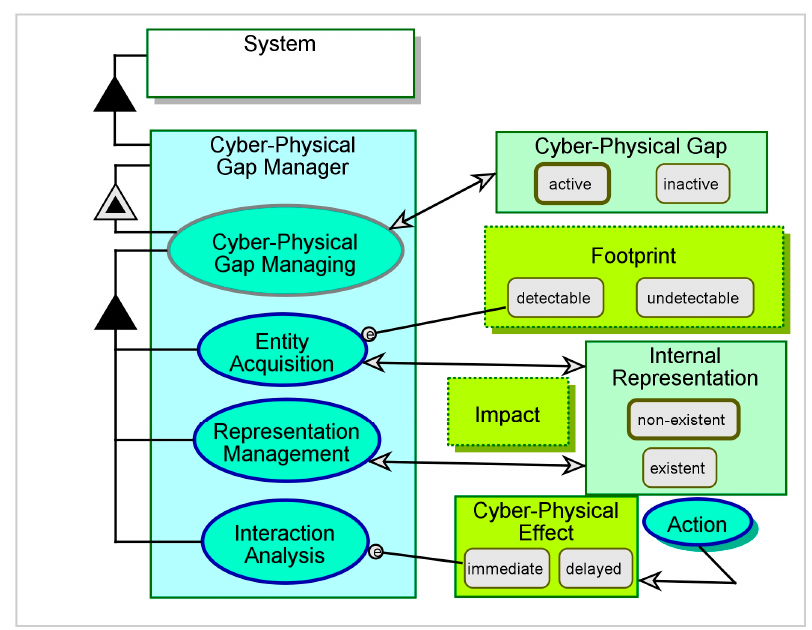
Figure 3. The Cyber-Physical Gap Managing process unfolded.